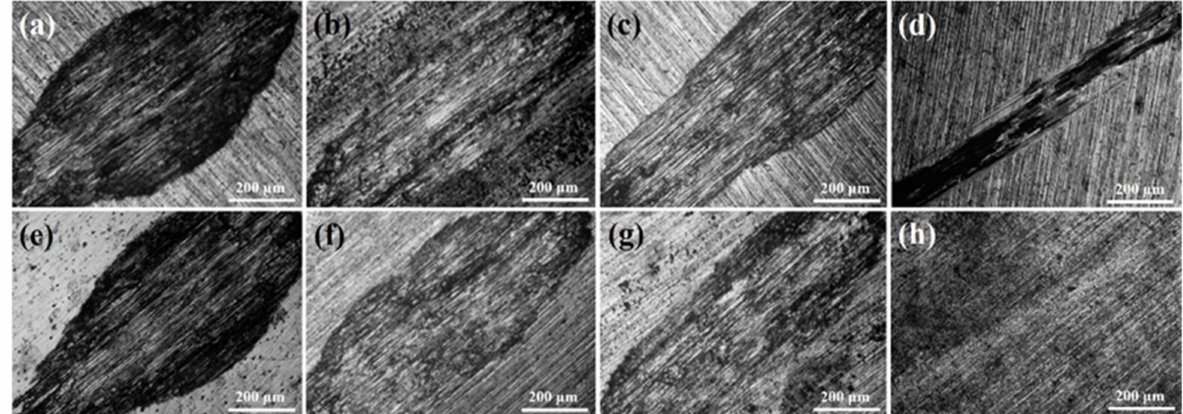
Figure 10. Worn surface morphologies of coatings observed by optical microscope: ( a ) as-deposited, ( b ) 200 ◦ C annealed, ( c ) 400 ◦ C annealed and ( d ) 600 ◦ C annealed Ni-Mo coatings; and ( e ) as-deposited, ( f ) 200 ◦ C annealed, ( g ) 400 ◦ C annealed and ( h ) 600 ◦ C annealed Ni-Mo coatings.